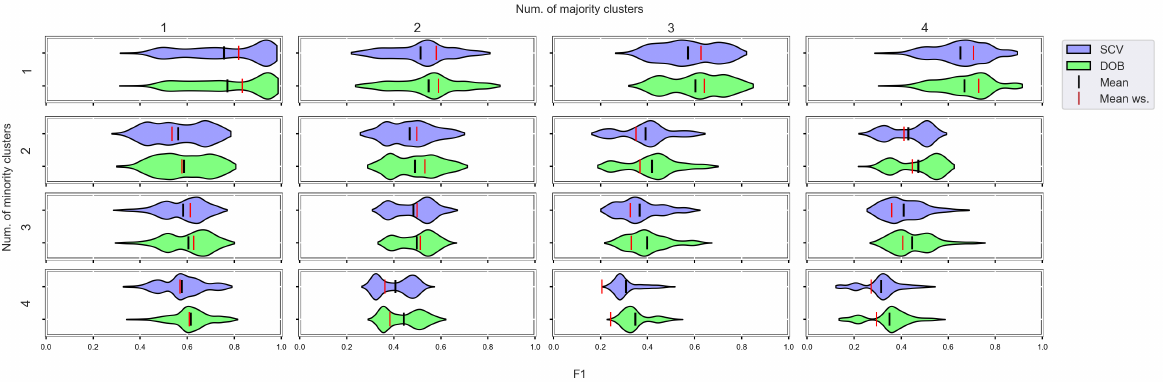
Figure A9. F 1 values concerning the number of clusters in the minority and majority classes in the case of the DTree classifier. (IR16).